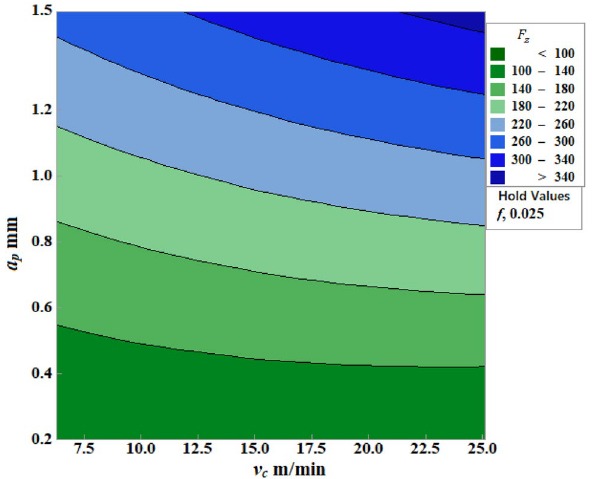
Table 5 ANOVA for analyzing F x versus v